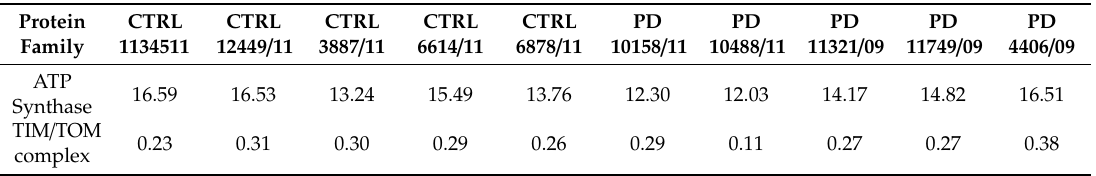
Table 2. Percentage intensity based absolute quantification (iBAQ) values of mitochondrial marker protein complexes. All samples show a similar percentage of both protein families, indicating comparable amounts of mitochondria in each sample. A detailed list of every protein assessed can be found in Supplemental Table